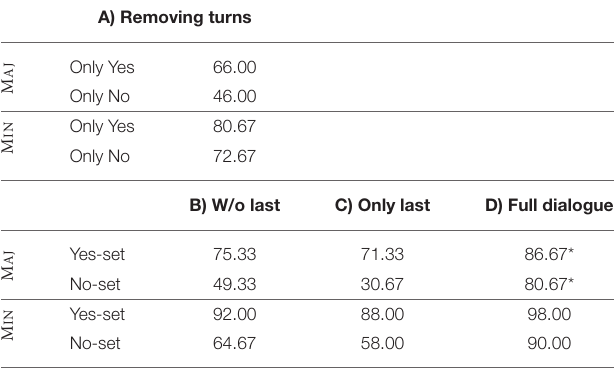
TABLE 5 | Humans’ performance on controlled sample: percentage of games guessed correctly by at least two participants ( M AJ ) vs. by at least one participant ( M IN ).